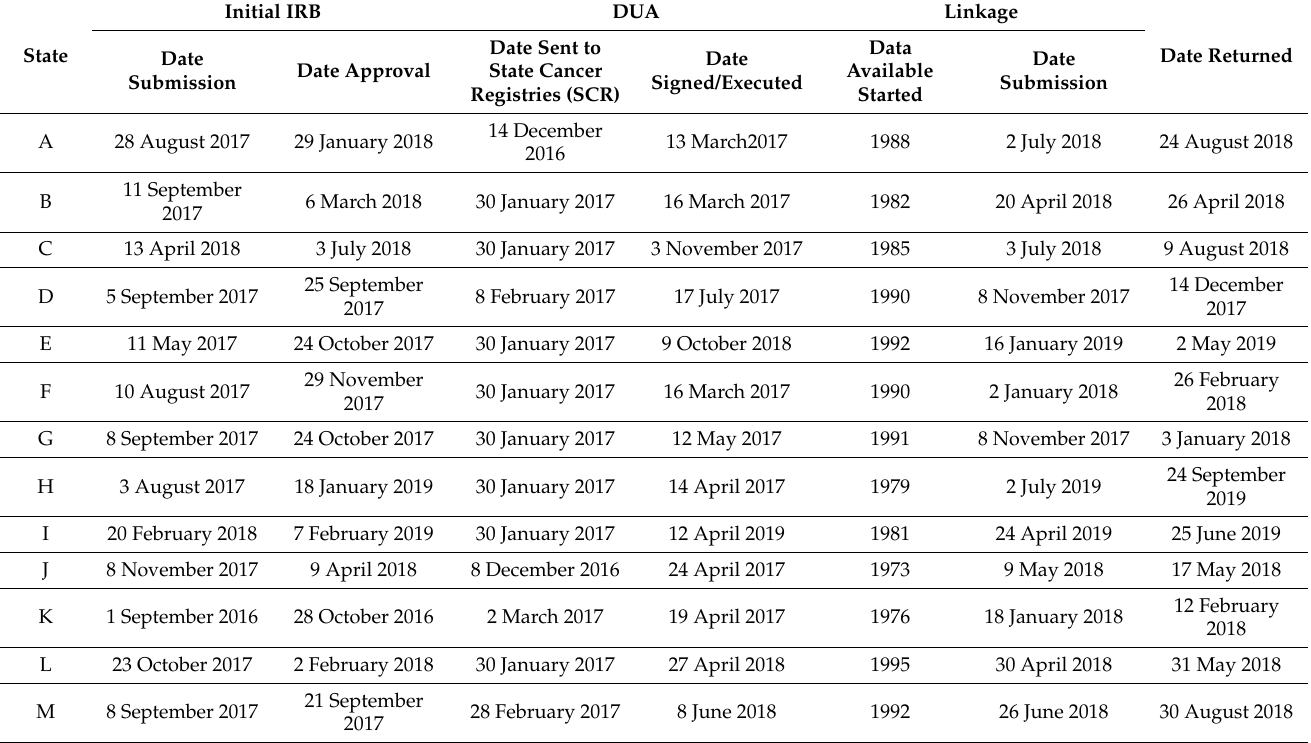
Table 1. Institutional Review Board (IRB) and Data Use Agreements (DUA) submissions and dates of approval and linkage dates of submission and date of return by state cancer